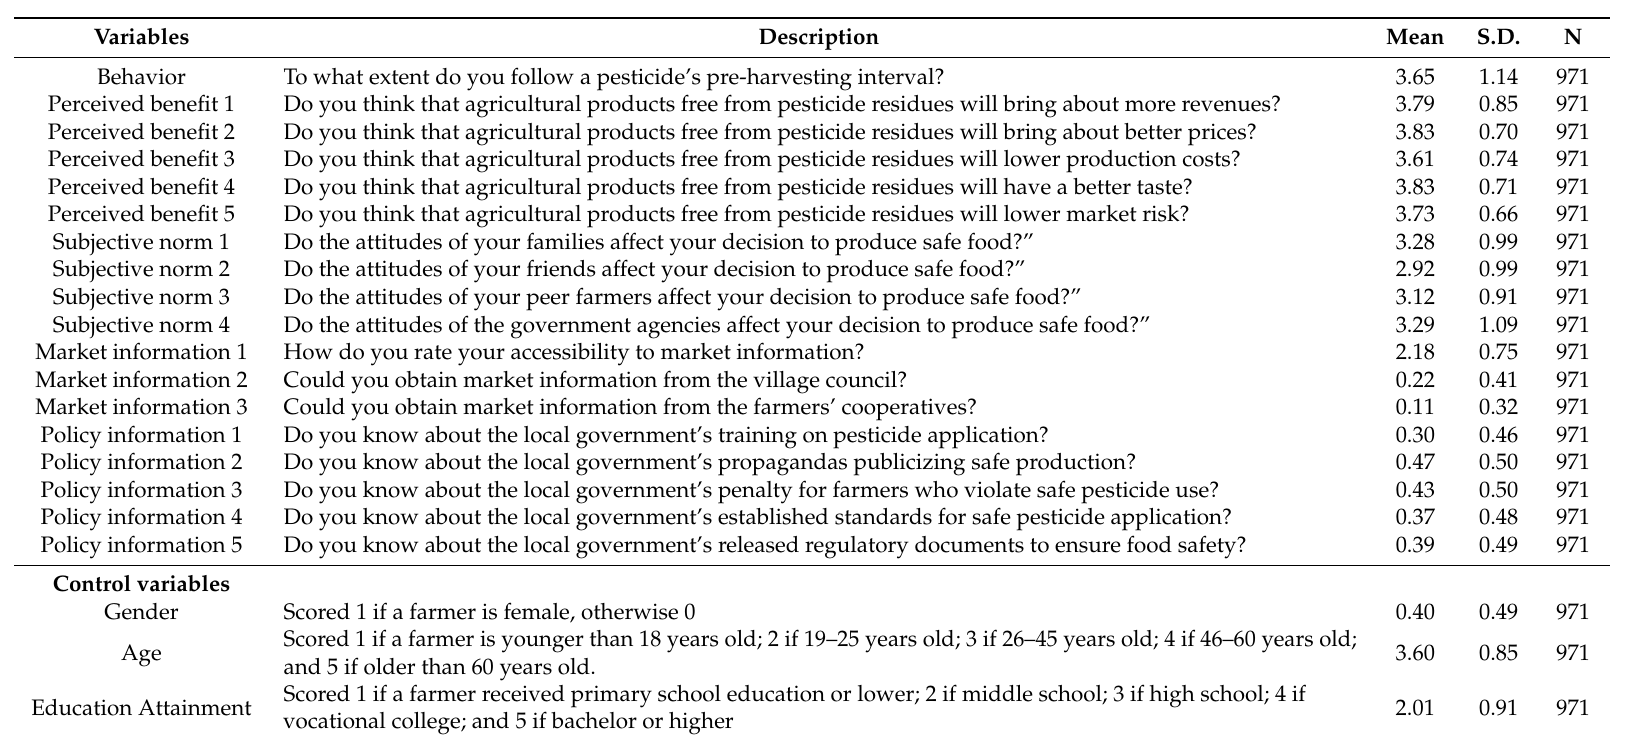
Table 2. Variable descriptions and summary